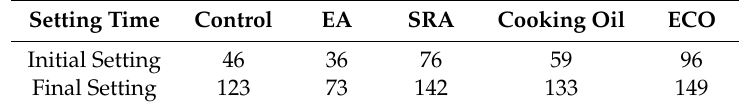
Table 6. Setting time of alkali-activated slag paste with di ff erent agents (minutes). Setting Time